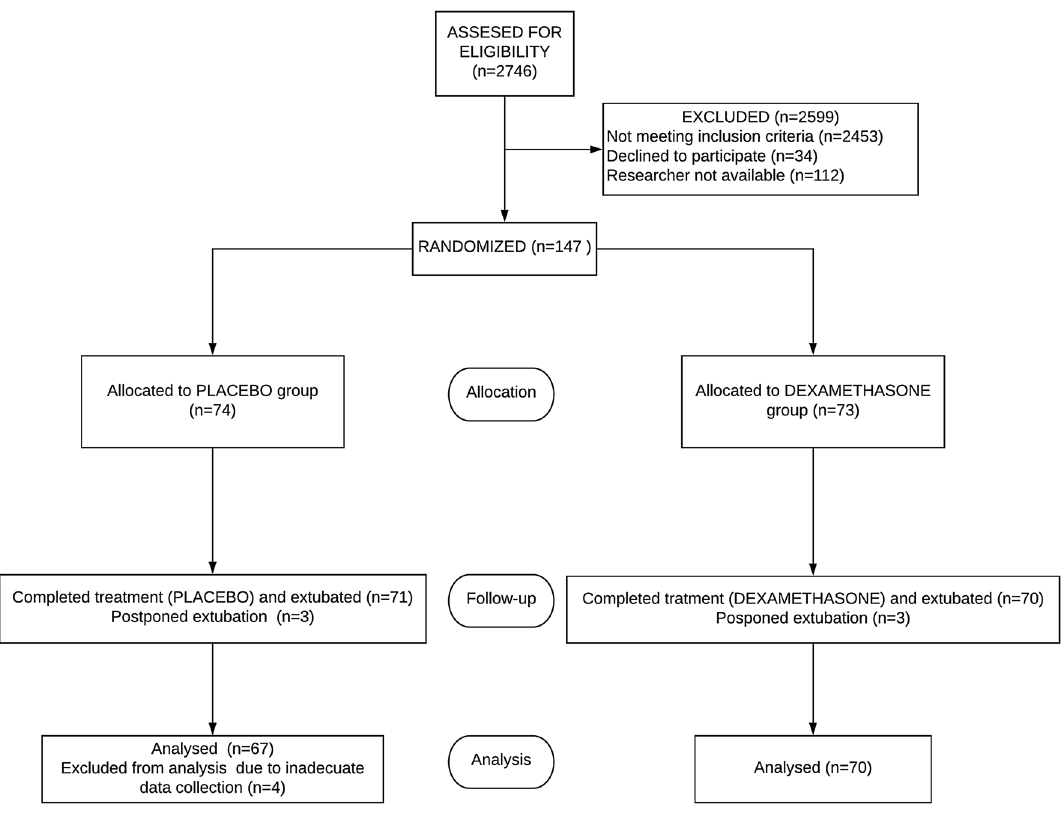
Figure 1. CONSORT flow